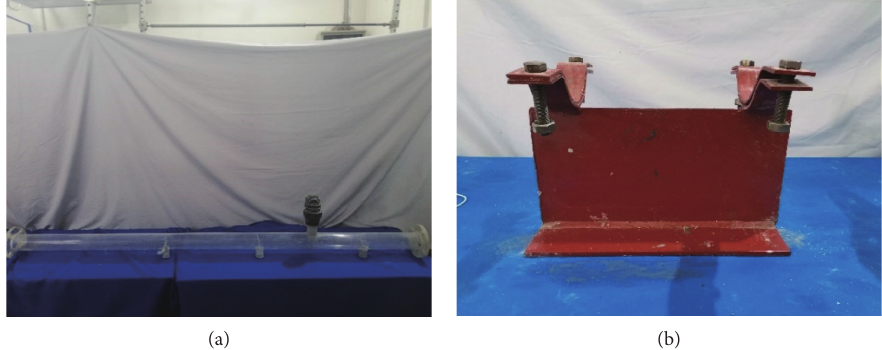
Figure 4: Simulation system for investigating pipeline fractures. (a) Organic glass pipeline. (b) Pipe bracket.